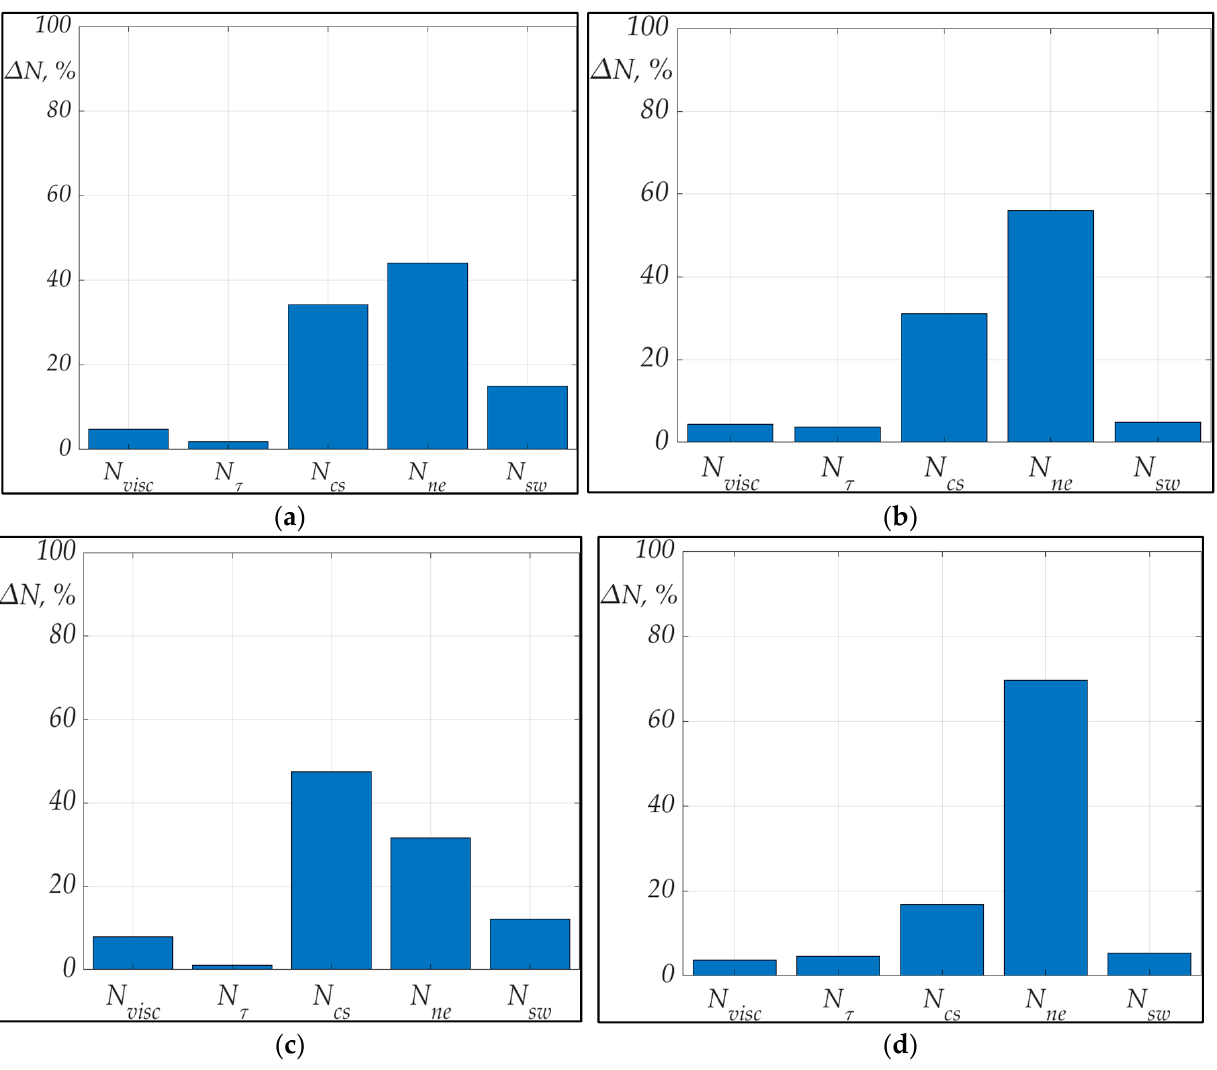
Figure 13. Power costs and losses distribution for ( a ) Ar ; ( b ) air ; ( c ) He ; and ( d ) CO 2 .